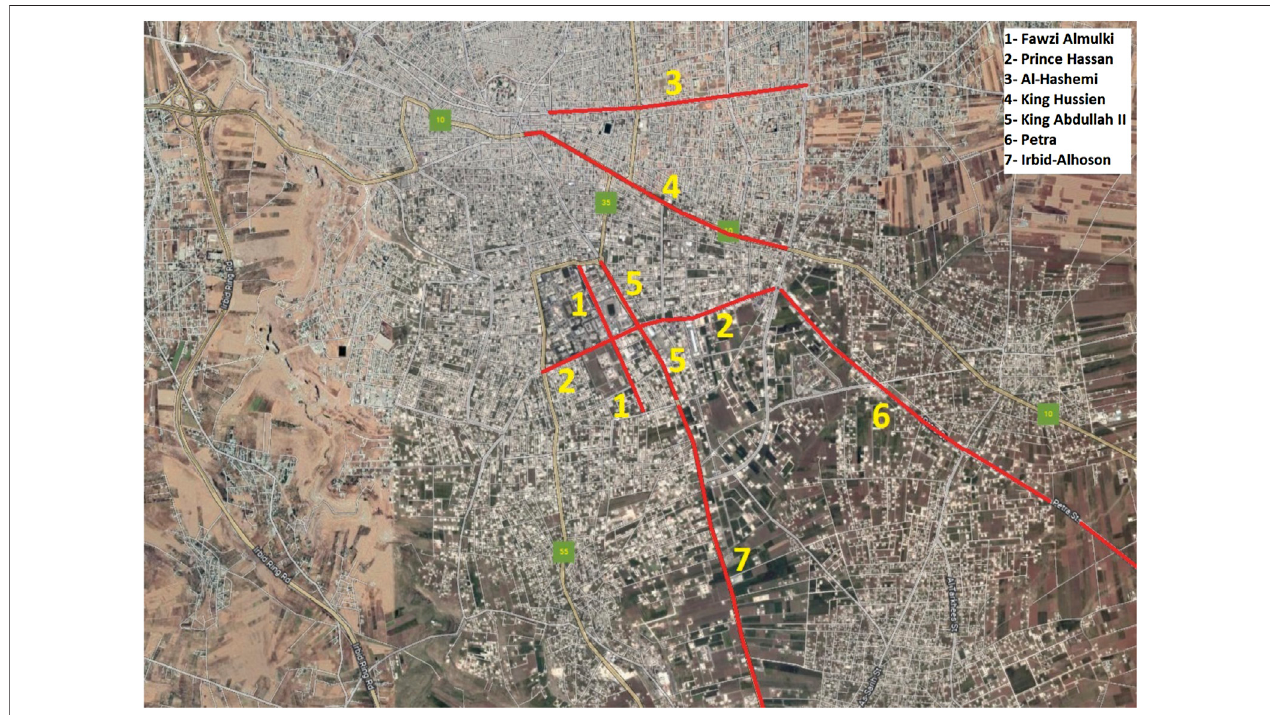
FIGURE 1 | Aerial photo for the hot spot locations (Google Map).